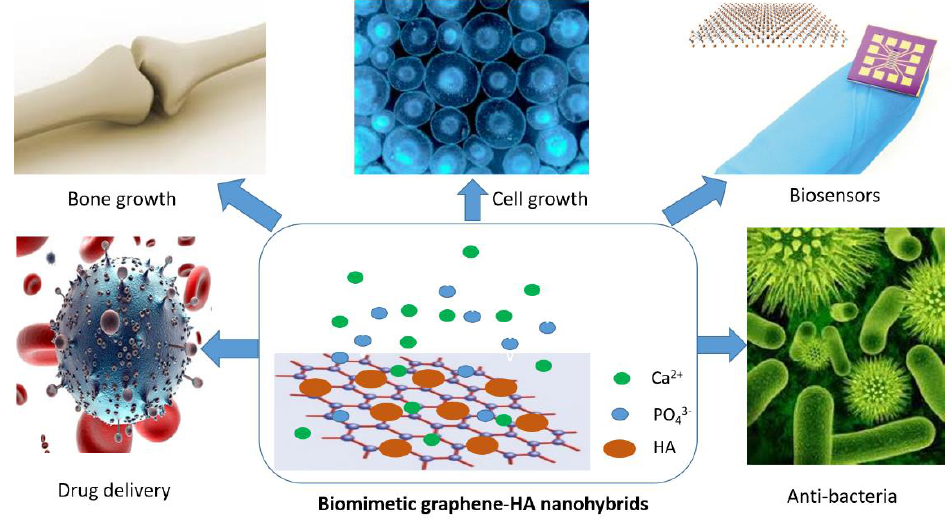
Figure 1. Biomedical applications of biomimetic graphene-HA materials.